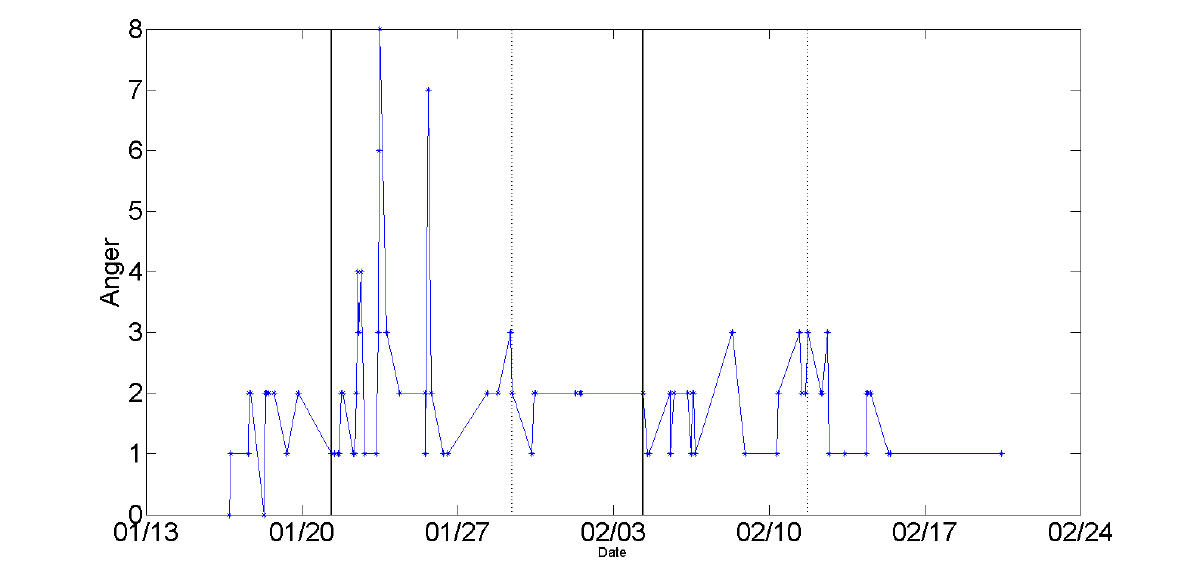
Figure 9. The majority of Forest’s mobile therapy